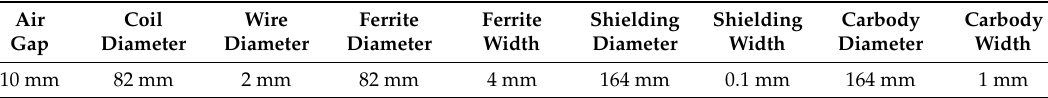
Table 1. Common values used in models.